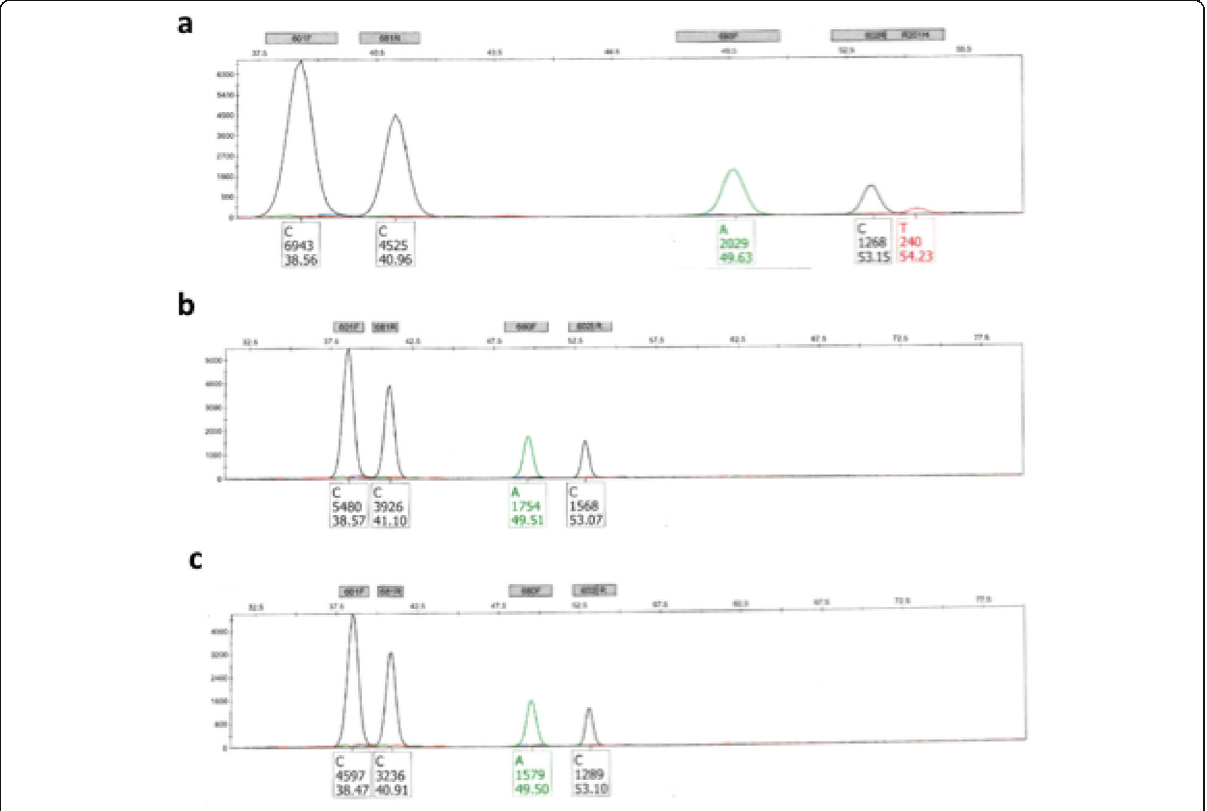
Fig. 4 Mutational status of GNAS gene in teratomatous LAMN, ovarian teratoma and appendix by SNaPshot analysis. In the teratomatous LAMN there was a c.602C > T (reverse) corresponding to a c.602G > A (forward) mutation in GNAS (a) while in the other tissues of the teratoma (b)